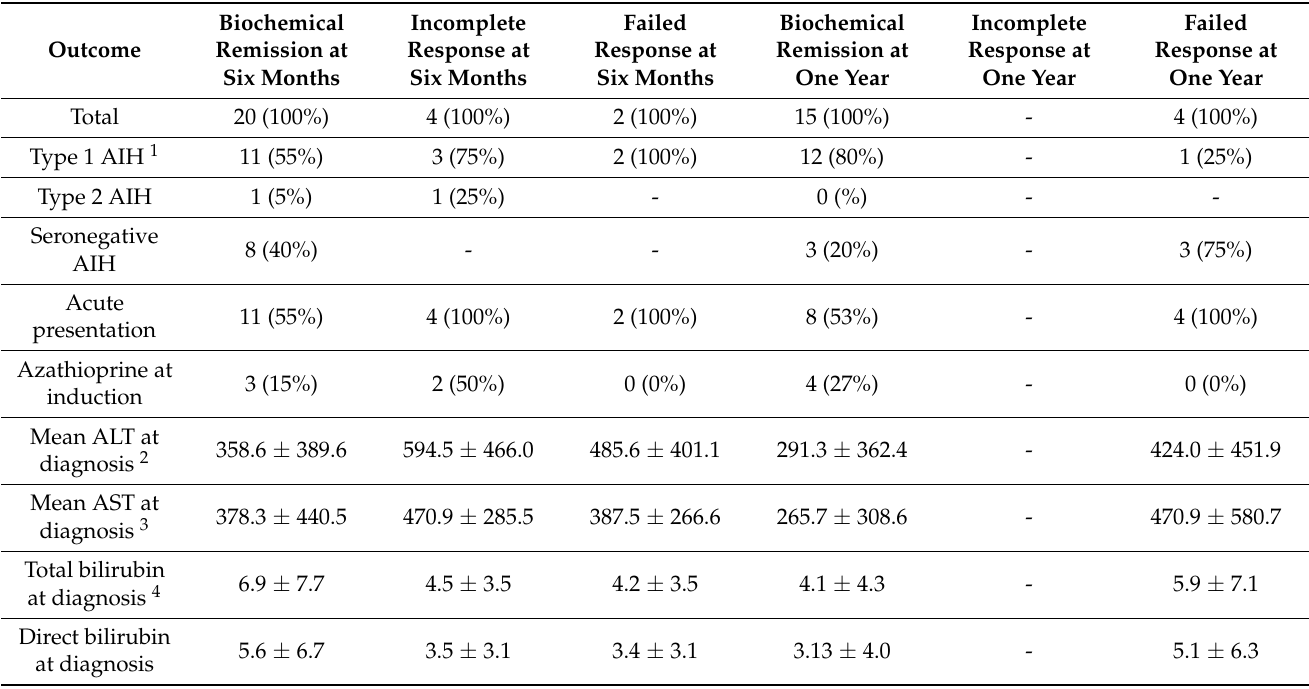
Table 3. Characteristics of the various laboratory panels at time of diagnosis stratified by autoim ‐ mune hepatitis (AIH) types in the study cohort.